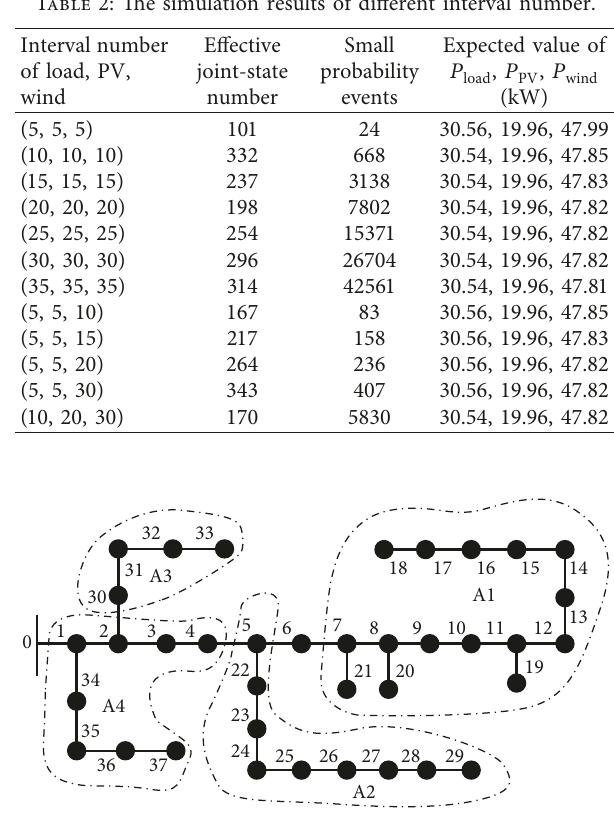
Figure 5: IEEE 37-bus